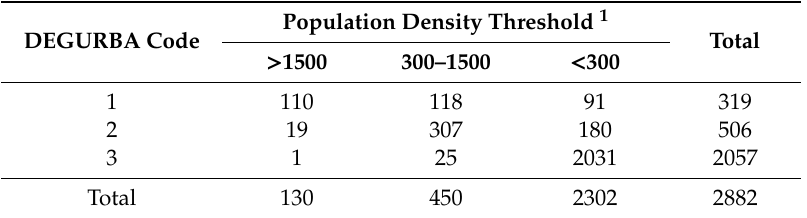
Table 1. Number of parishes by DEGURBA classification and population density.